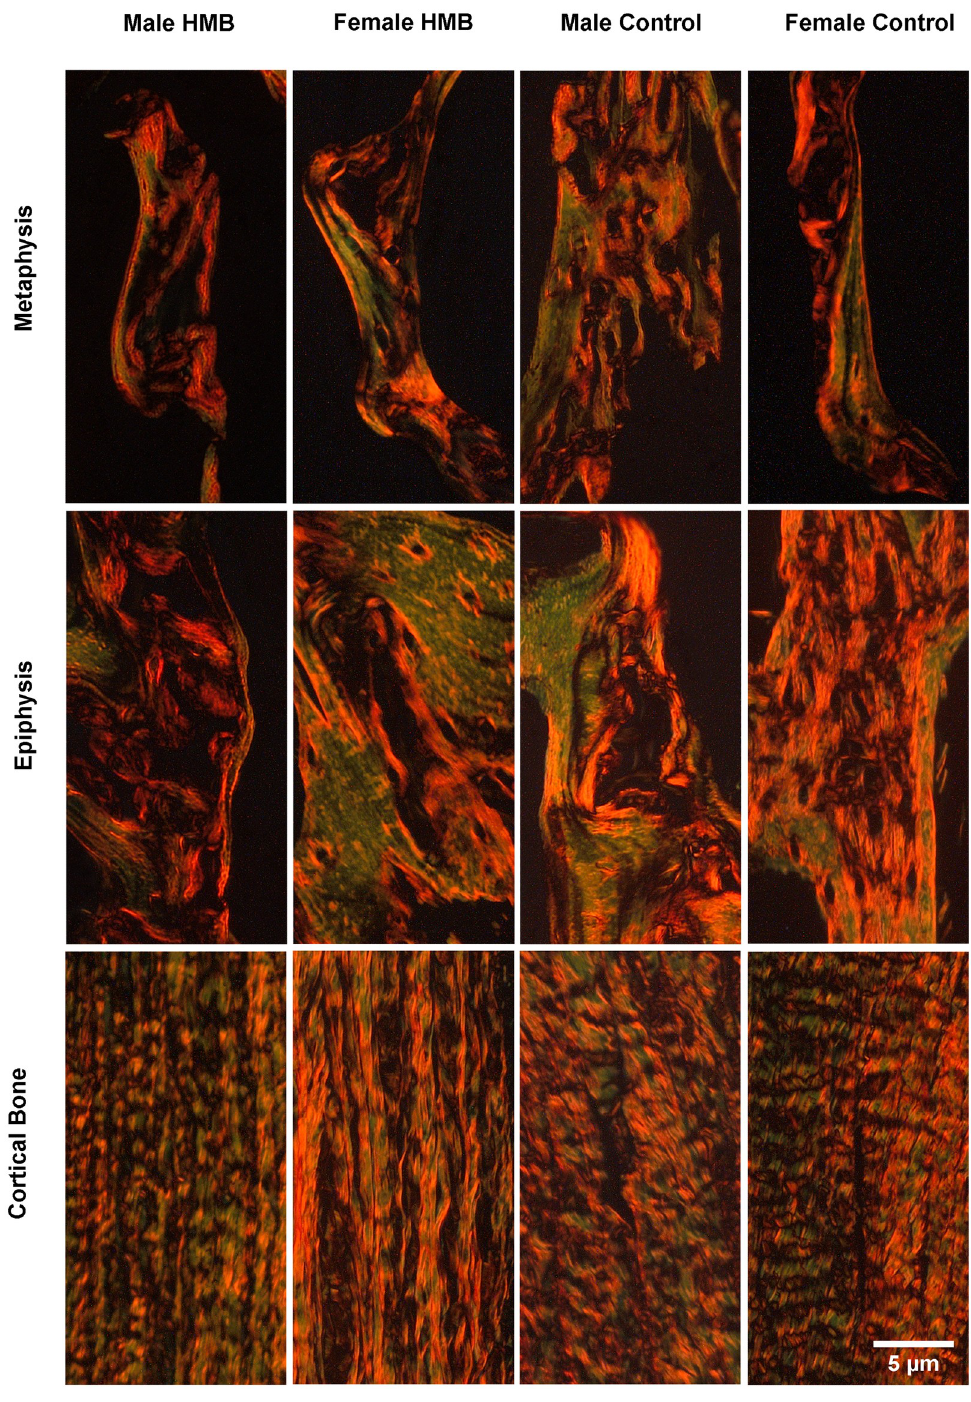
Fig 1. Representative images of PSR (Picrosirus red) staining carried out on formaldehyde-fixed fragments sections of the trabecular bone of the humerus metaphysis, epiphysis and the cortical bone of newborn piglets. Mature collagen fibers are red or orange, while immature collagen fibers are